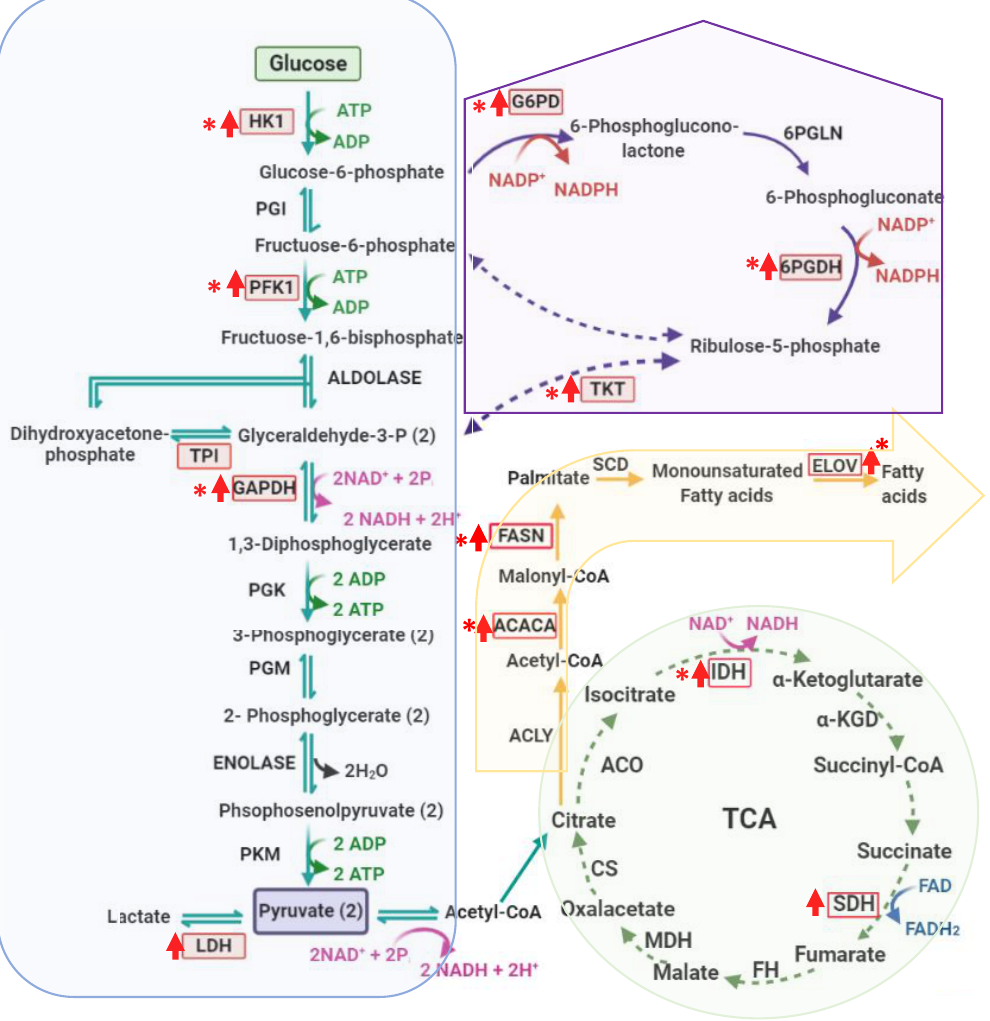
Figure 4. Metabolic routes relevant to this study. The genes analyzed in this study are shown in a red box, red arrows indicate genes that showed overexpression, and an asterisk represents those genes that showed an increase in the level of expression regarding the CNS WHO grade of the brain glioma biopsies. The gliomas undergo metabolic remodeling to meet the needs of the highly proliferative cells, which can be summarized as an increase in the expression of some genes involved in glycolysis, such as HK1 , PFKM , GAPDH , and LDHAL6A . Besides this, the overexpression of some genes involved in PPP was also demonstrated ( G6PD , PGD1 , and TKT1 ), which will probably allow the glioma cells to have a more significant enzymatic activity in this pathway, and thus the cells obtain precursors for nucleotide synthesis and reducing power. Finally, the Krebs cycle and fatty acid synthesis pathways play central roles in cellular metabolism; we also found that the IDH1 , SDHB , FASN , ACACA , and ELOVL2 genes were overexpressed, resulting in significant disturbances in the cellular metabolism of gliomas.